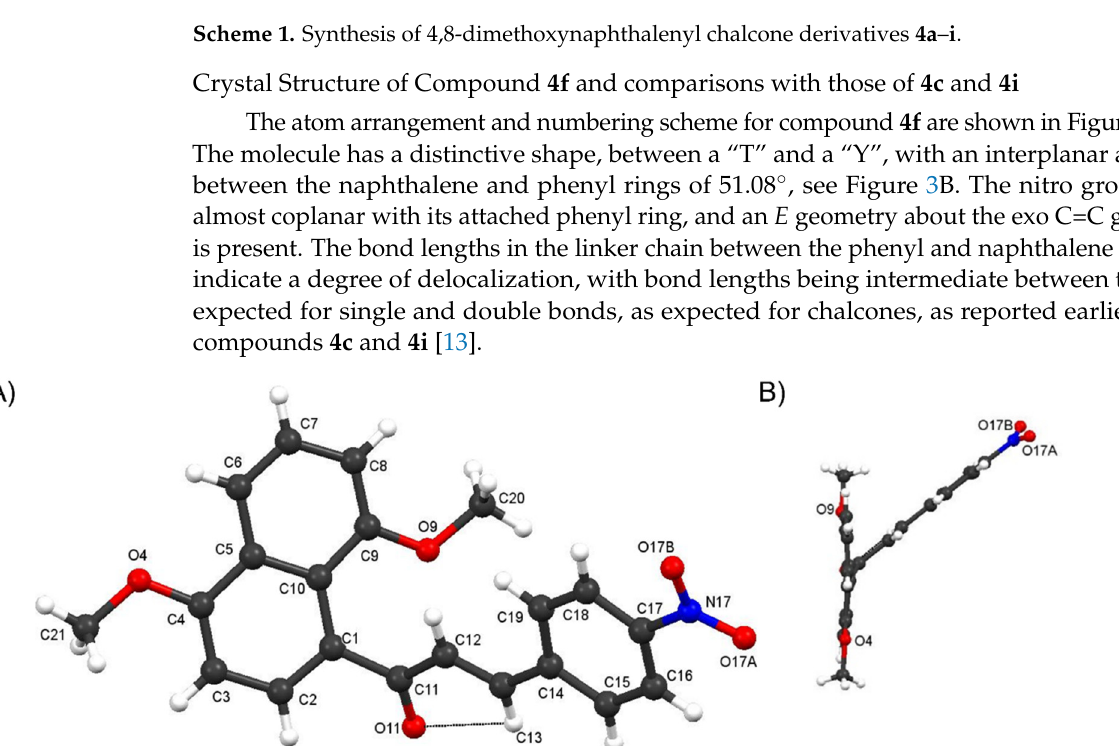
Figure 3. ( A ) The atom arrangement and numbering scheme for compound 4f . ( B ) Interplanar angle between the naphthalene and phenyl rings of compound 4f .